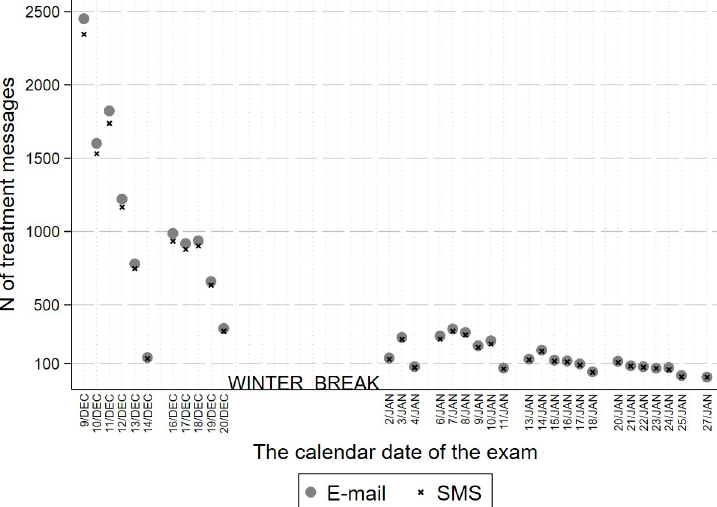
Fig 3. The total number of treatment messages (e-mail and SMS) corresponding to an exam on a particular calendar date. Note: E-mail messages were sent out at 8 pm the day before the exam. Text messages (SMS) were sent out at 7 am on the day of the exam. N of treatment e-mail = 14,974. N of treatment SMS =